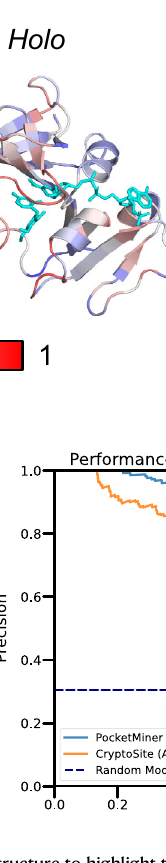
structure to highlight that those high predicted labels cluster near the ligand binding site. B PocketMiner correctly predicts that the probability of pocket for- mationislowforahighlyrigidhelicalbundle (PDB:4TQL 79 )thatdidnotformlarge cryptic pockets in simulation. C Receiver Operating Curve for residue-level cryptic site detection shows that PocketMiner achieves a better performance than Cryp- toSite despite running >1000x faster. D A precision-recall curve highlights that at high levels of recall (0.6 – 0.8) PocketMiner predicts fewer false positives. Source data are provided as a Source Data fi